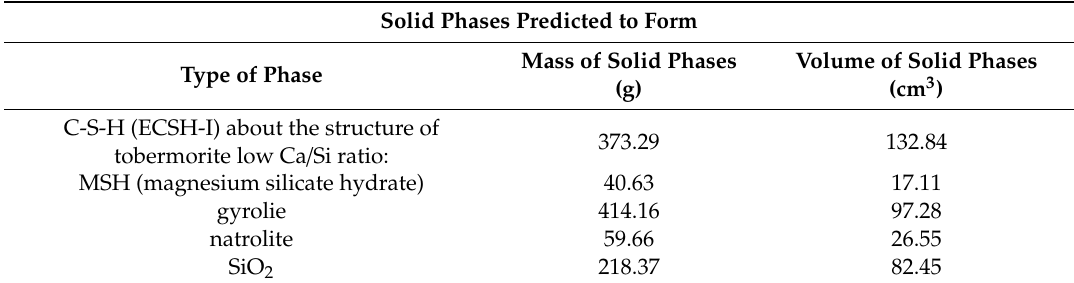
Table 6. Thermodynamic (geochemical modeling, GEMS) simulation results obtained at 20 ◦ C.